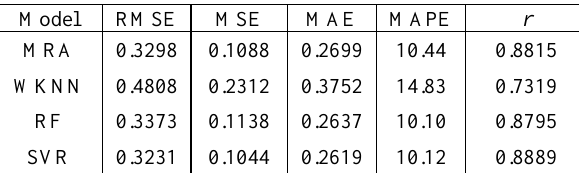
Table 2. Evaluation criteria for the basic models